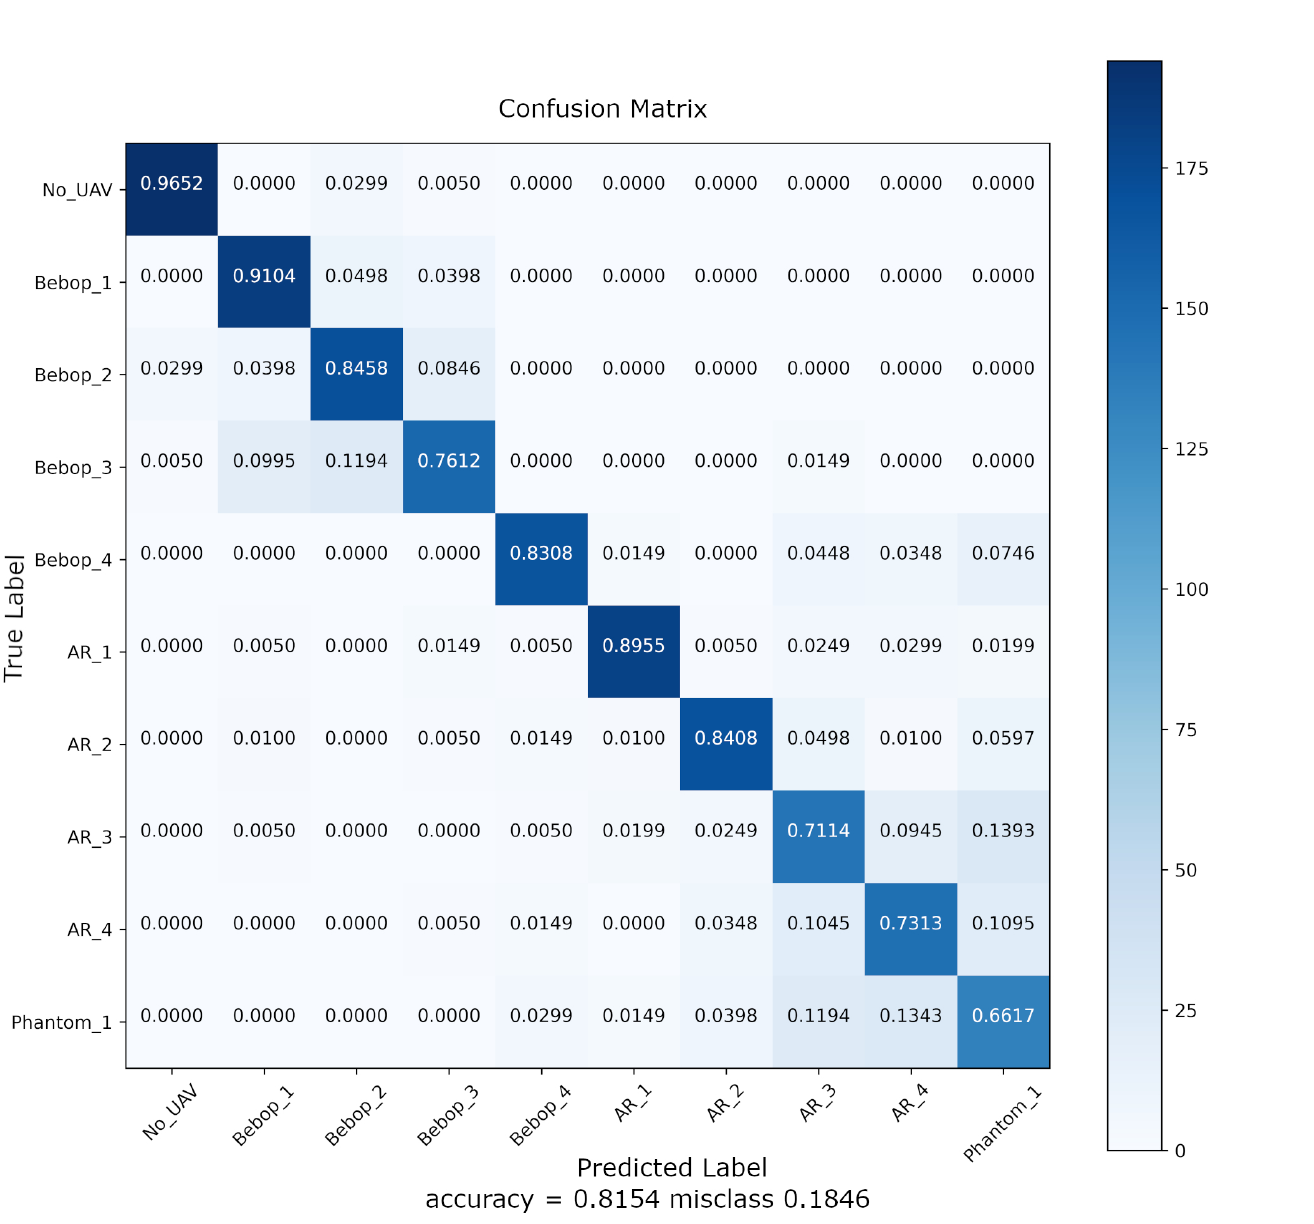
Figure 19. Confusion Matrix